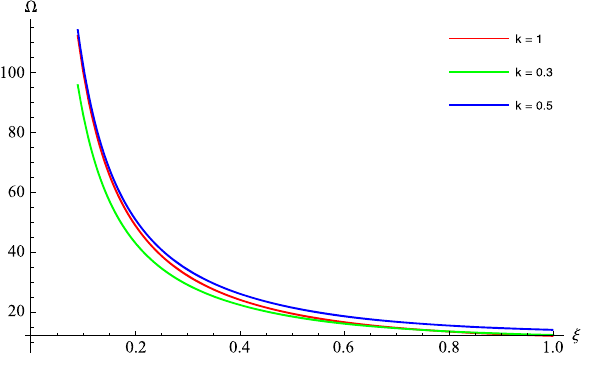
can be depicted through some of the applications listed below.